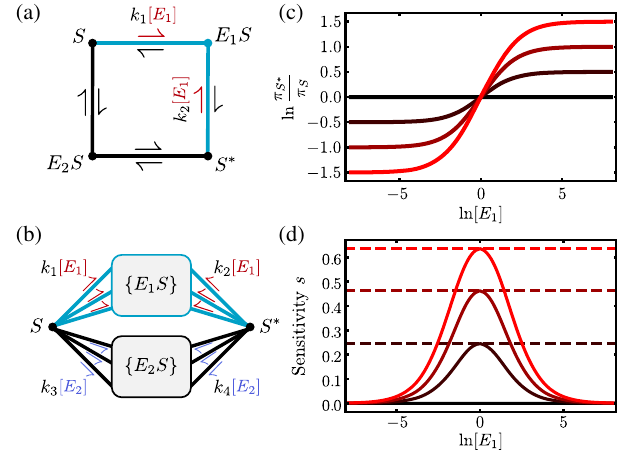
FIG. 4. Sensitivity of a biochemical switch. Modification- demodification cycle with (a) a single intermediate or (b) general enzymology. Perturbations of ½ E 1 (cid:3) -dependent rates (red arrows) can be parameterized by blue vertex and edge perturbations. (c) Single-cycle switchlike behavior of ln ð π S (cid:4) = π S Þ as a function of ln ð½ E 1 (cid:3)Þ , with redder curves representing larger chemical driving Δ μ . (d) Sensitivity s ¼ j ∂ ln ð π S (cid:4) = π S Þ = ∂ ln ð½ E 1 (cid:3)Þj as a function of ln ð½ E 1 (cid:3)Þ for the same values of Δ μ , compared to the predicted bound (22) (dashed